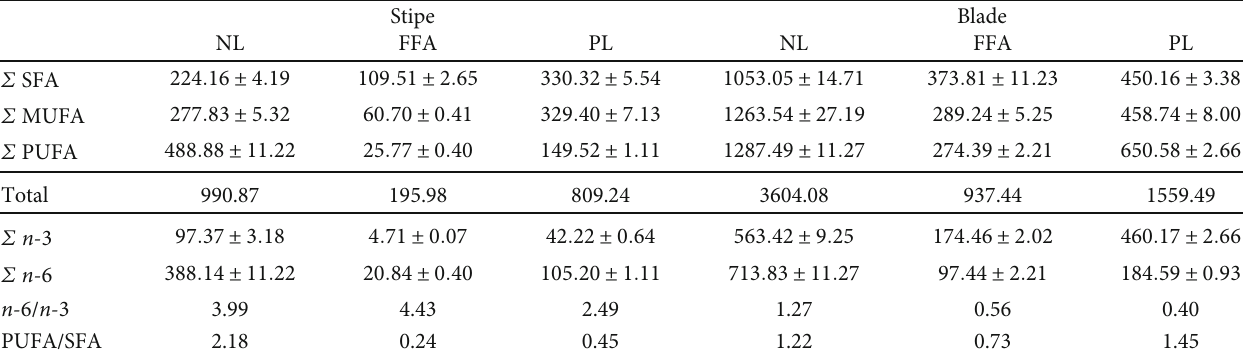
Table 2: Sum of SFAs, MUFAs, and PUFAs, as well as n -6 and n -3 in L. hyperborea given in μ g/g DW, ( n = 4 , two injection parallels for each sample